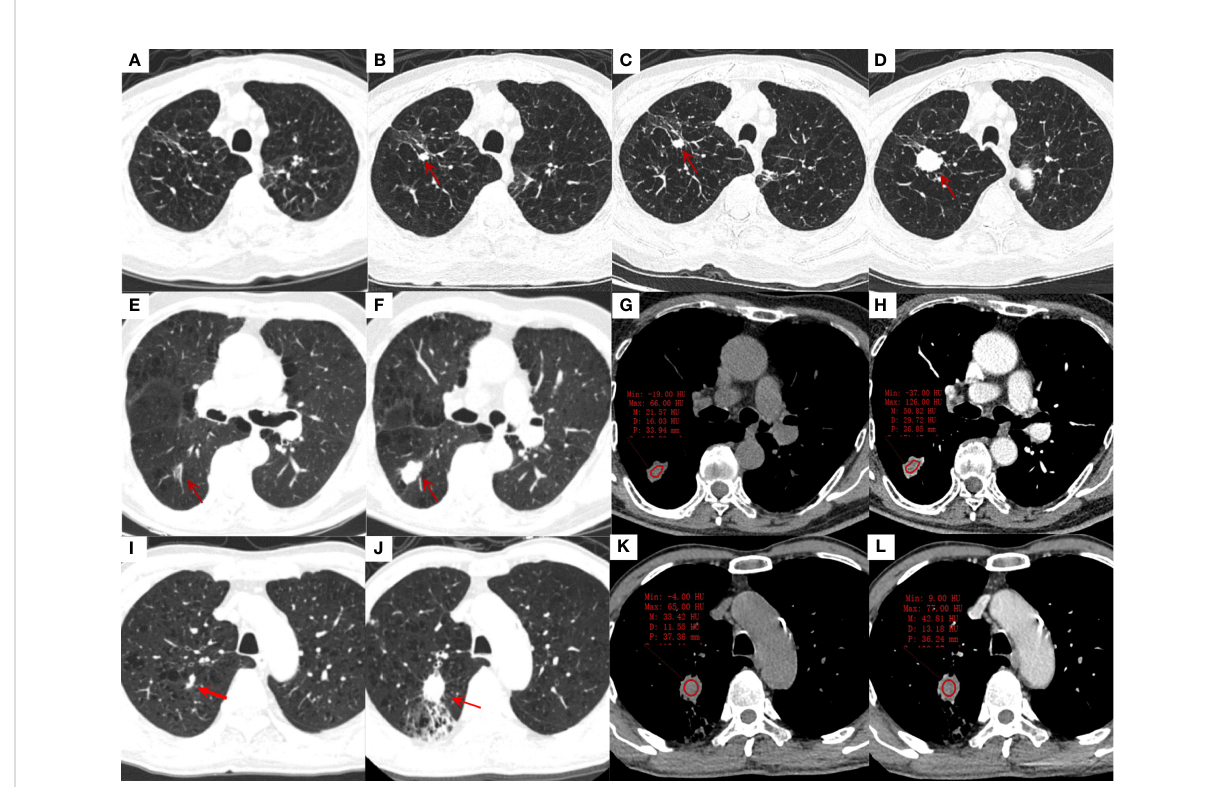
FIGURE 2 Transverse thin-section CT scans in the diagnosis of lung cancer in a lobe affected by tuberculosis. (A-D) , an 85-years-old male with stable tuberculosis; (A) : The fi rst CT scan of the patient showed a few irregular linear and ground glass opaci fi cation in the right upper lung; (B) : CT scan was reexamined 4 years later, showing a new solid nodule (red arrow) with a diameter of 9 mm and lobulations in the original tuberculosis focus area; (C, D) : CT were reexamined 3 months and 8 months after the discovery of the nodule. The nodule was gradually enlarged, and small cell lung cancer was proved by bronchoscopic biopsy. (E-H) , an 82-years-old male with stable tuberculosis; (E) : a ground glass nodule (red arrow) with 16mm in length and vessel convergence was found in the dorsal segment of right lower lung on the fi rst CT scan; (F) : the ground glass nodule was enlarged to solid nodule with 23mm in length, lobulations and spiculations after 4 years, adenocarcinoma was diagnosed by surgical biopsy. (G, H) : The non-enhanced and enhanced CT value of nodule was 22 HU and 51 HU, respectively; moderately heterogeneous enhancement can be seen after enhancement. (I-L) , a 68-years-old male with stable tuberculosis; (I) : a small solid nodule beside the vessel with 5 mm in length in the posterior segment of right upper lung was misdiagnosed as fi brous tubercle on the fi rst CT scan; (J) : the nodule was obviously enlarged with 25 mm in length and distal obstructive pneumonia after 3 years, adenocarcinoma was diagnosed by surgical biopsy. (K, L) : The non-enhanced and enhanced CT value of nodule was 33 HU and 43 HU, respectively, ring-like enhancement can be seen after